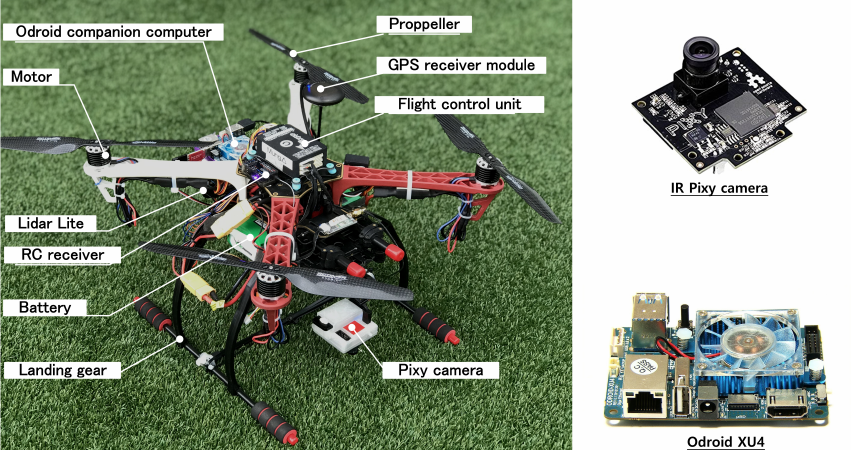
Figure 4. The experimental quadcopter platform and its equipped